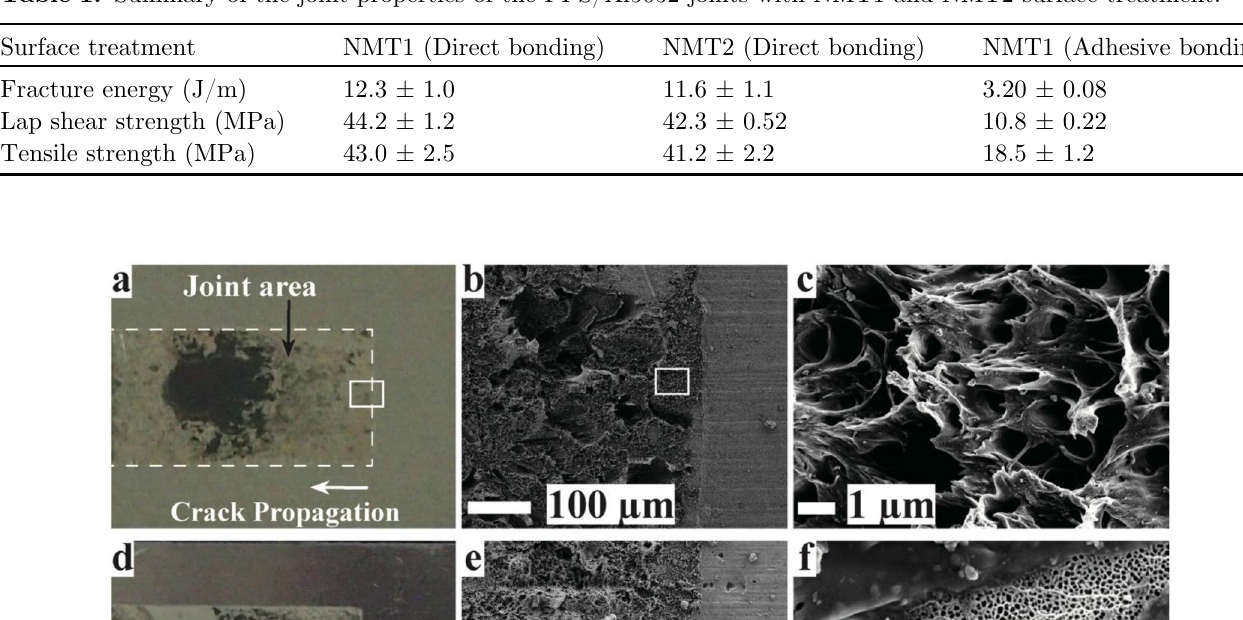
Table 1. Summary of the joint properties of the PPS/Al5052 joints with NMT1 and NMT2 surface treatment.